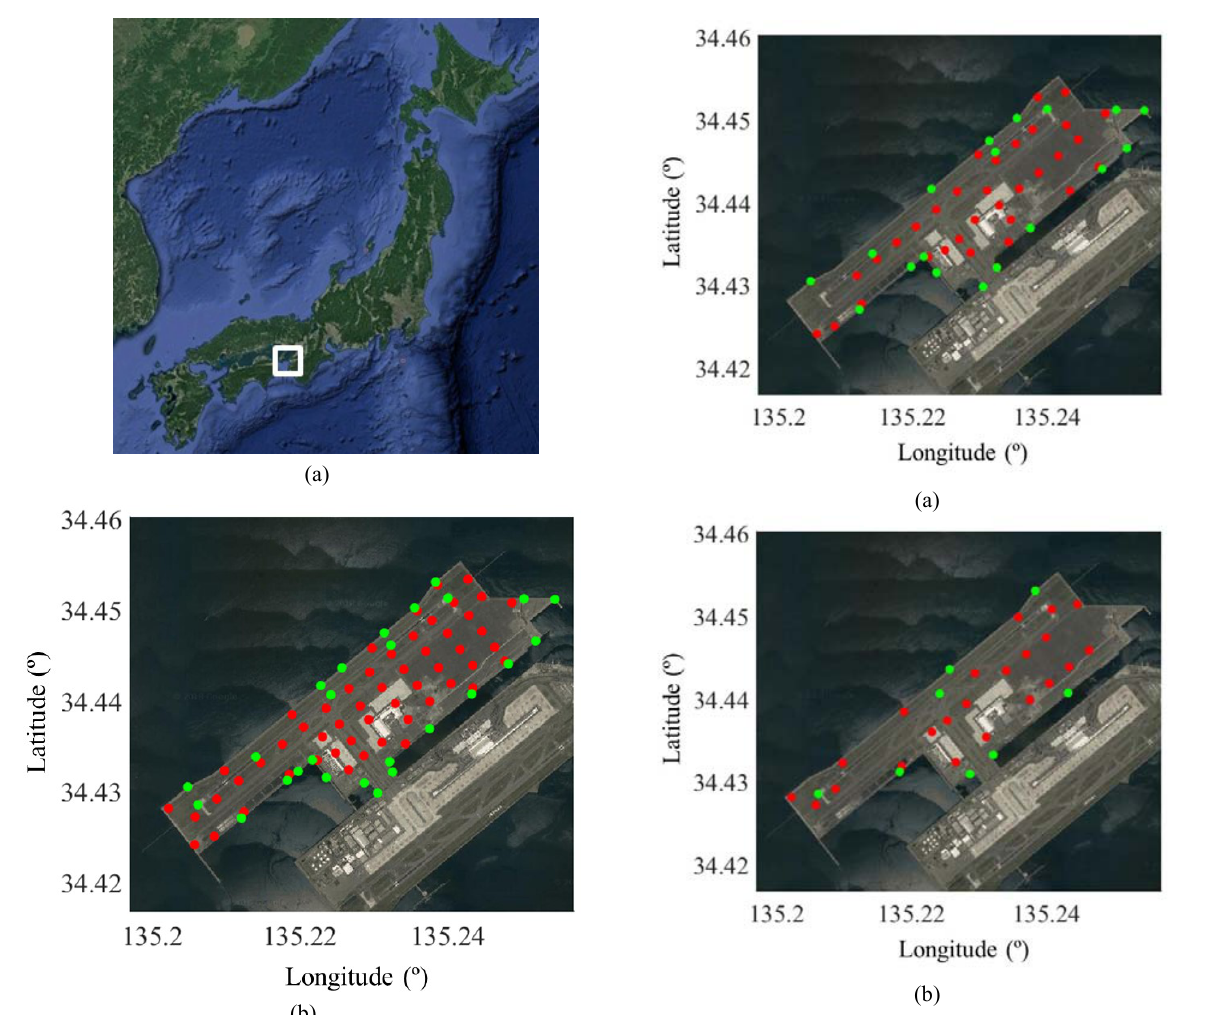
Figure 5. Locations of geodetic data used for (a) interpolation and (b) validation. Red and green dots represent leveling and GPS locations, respectively.